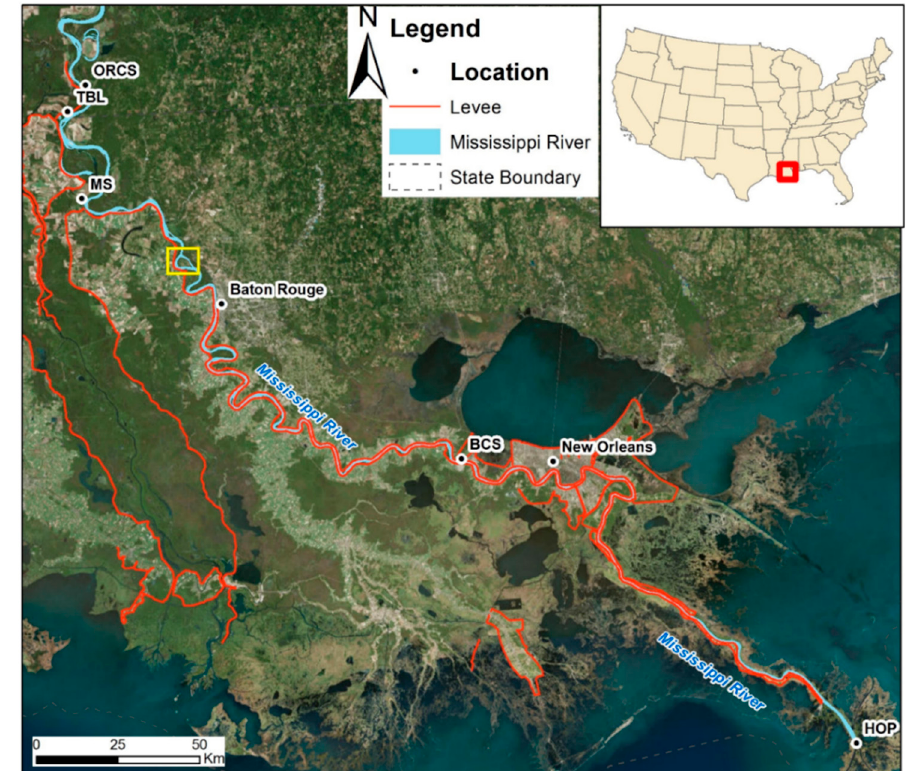
Figure 1. The geographical map of the lowermost Mississippi River (LMR) with different locations. Artificial levees along the channel (red lines) are also marked in this map. Our study reach (river kilometer (RK) 490 to RK 0) is located from downstream of Tarbert Landing (TBL, RK 493) to the Head of Passes (HOP, RK 0). Some important structures are also labeled on the map, such as Old River Control Structure (ORCS, RK 500), Morganza Spillway (MS, near RK 451), and Bonnet Carré spillway (BCS, near RK 205), as well as the two cities of Baton Rouge (RK 370) and New Orleans (RK 164). The yellow square indicates the location for Figure 4B.